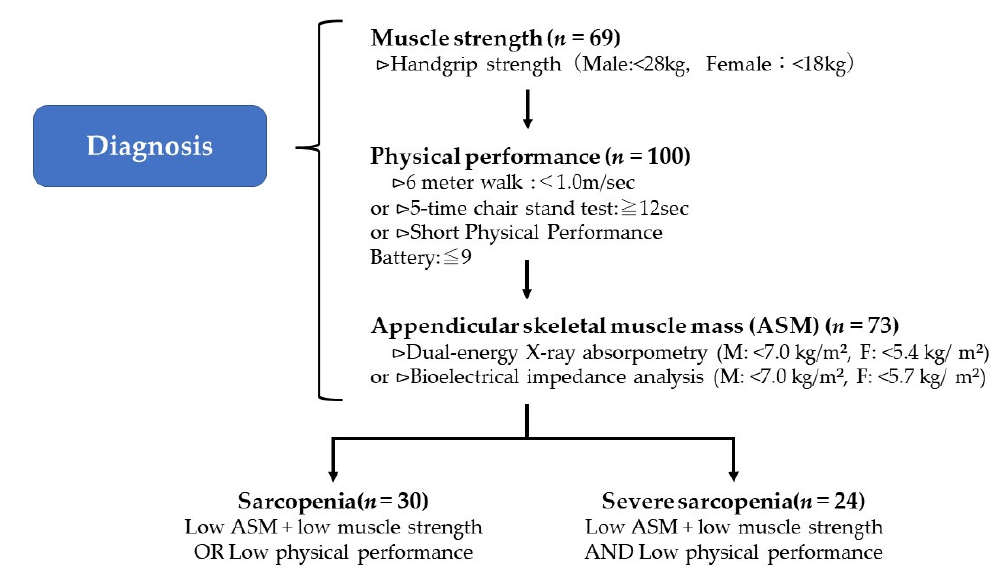
Figure 2. AWGS2019 criteria for the diagnosis of sarcopenia.